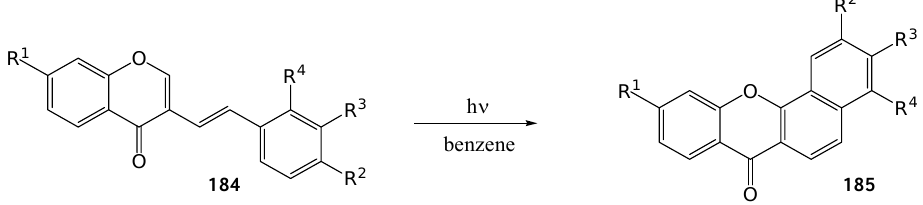
Table 14. Effect of substituents on the yield of the photocyclization of 2-styryl-4 H -chromen-4-ones.